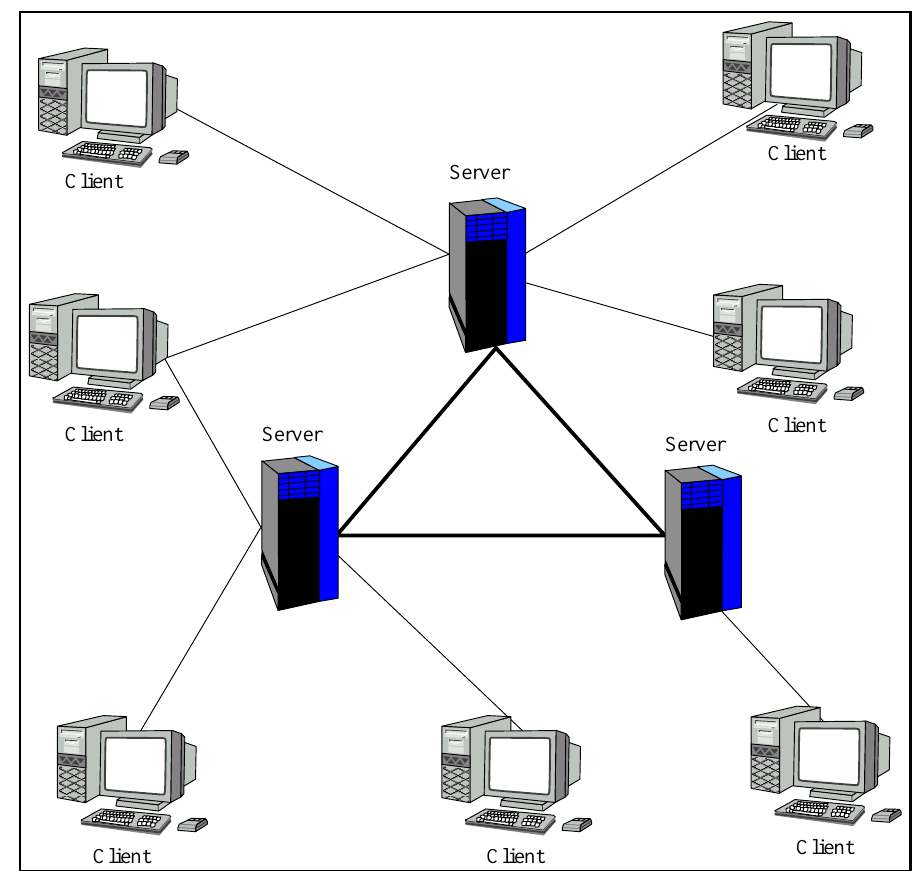
Figure 4: Network of collaborative systems build from PARIS. This makes it possible for us to exchange and share the data and experience